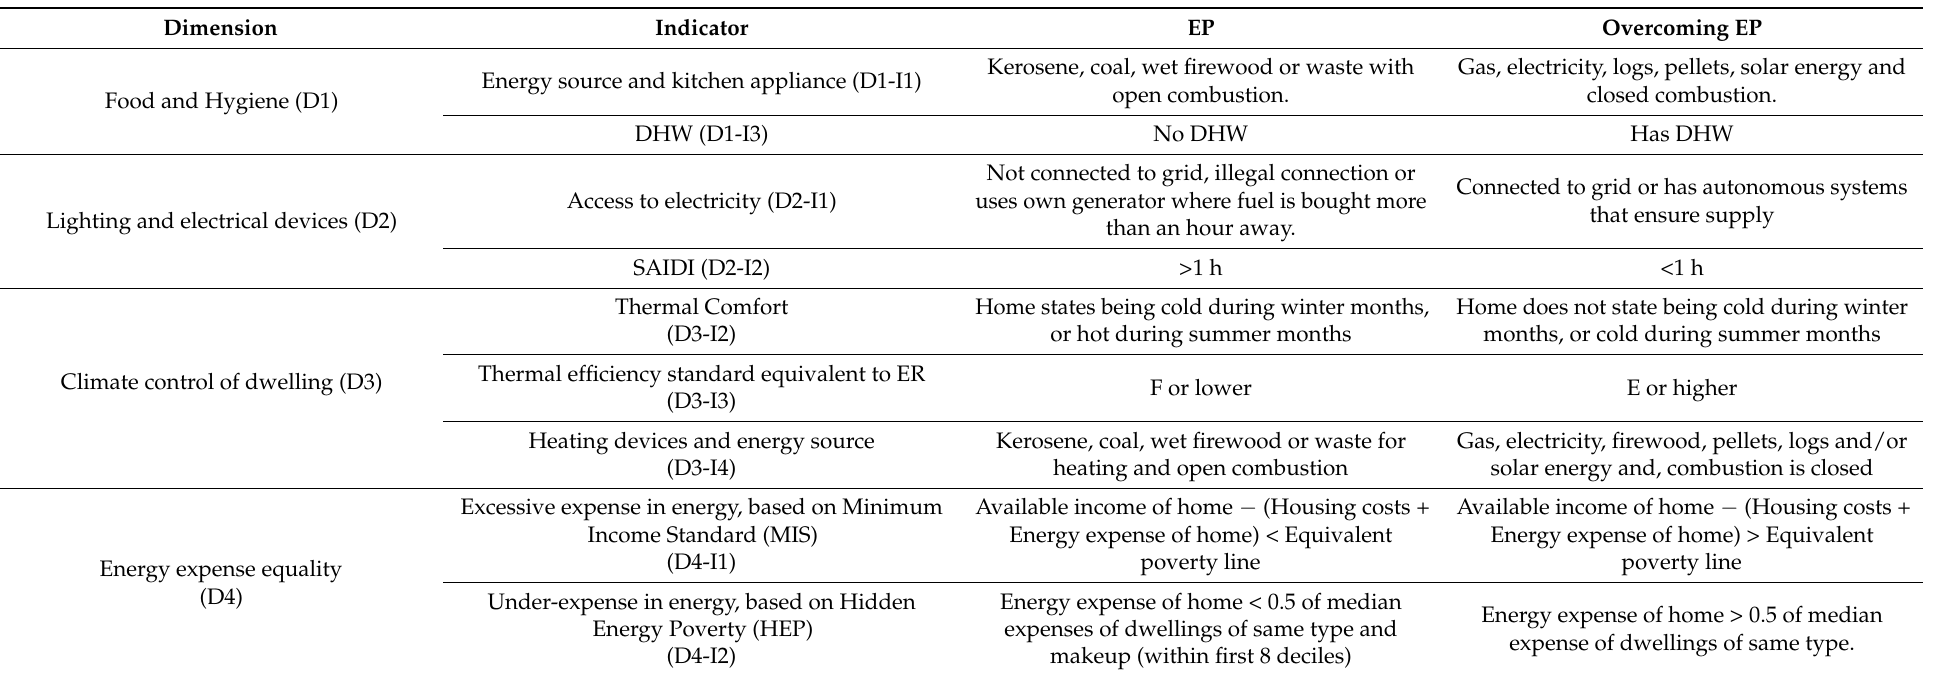
Table 1. EP Three-dimensional and Territorialized Indicator (EPTTI), created by RedPE